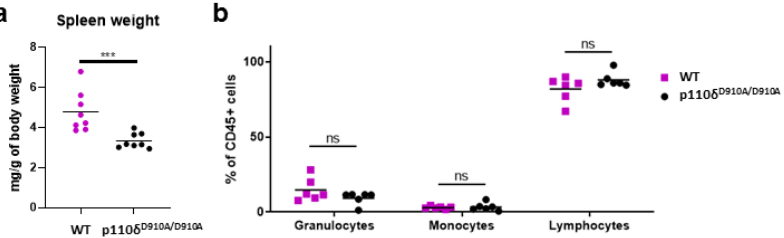
Figure 1. ( a ) Reduced weight of spleens in p110 δ D910A/D910A mice. The graph shows weight of spleens in p110 δ D910A/D910A mice (black dots) compared with their respective wild-type littermates (WT, purple dots). The spleen weights are expressed as mg/g of body weight. Results are shown as means with individual values. Mann–Whitney analysis disclosed significant differences between groups; n = 8. ( b ) Flow cytometry analysis of white blood cell percentages in the blood of p110 δ mice (black dots) compared with their respective wild-type littermates (purple dots). The values are expressed as percentage of CD45+ cells. Statistical significance was determined by two-way ANOVA followed by Sidak multiple comparison test; n = 6. Results are shown as means with individual values. Ns—non-significant ( p > 0.05), *** p ≤